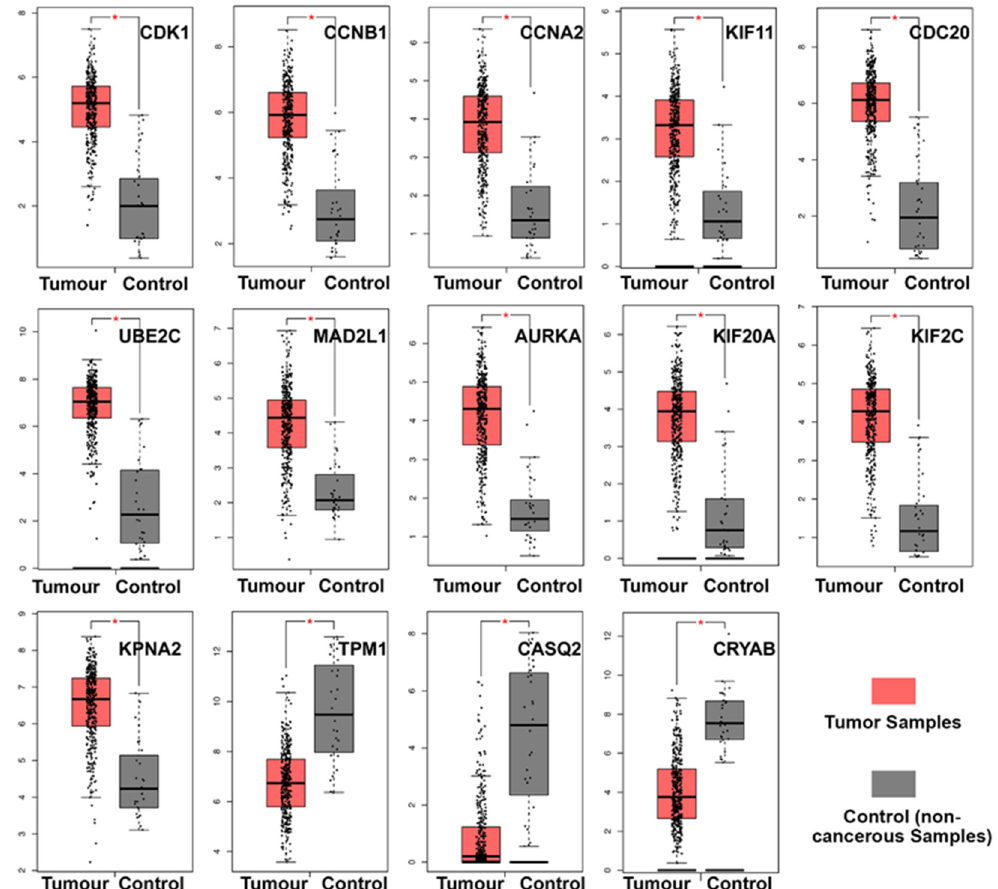
Figure 5. Box plots of gene expression levels for hub genes in noncancerous bladder samples and BCa samples. Y-axis = Log2 (TPM + 1). Control means the noncancerous samples from TCGA-BLCA ( n = 19) and GTEx ( n = 9). Tumor tissue, marked in red ( n = 404), is also originally from TCGA-BLCA, with noncancerous tissues marked in gray ( n = 28), and a red * indicating a p -value < 0.01. TPM = transcripts per million.